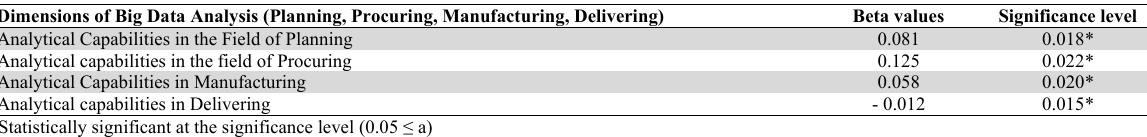
Analysis of the results of multiple regression of the direct impact of big data analysis on the performance of the supply chain in Saudi industrial companies in light of the presence of the orientation of the processes and the use of information systems as intermediate variables Dimensions of Big Data Analysis (Planning, Procuring, Manufacturing, Delivering)